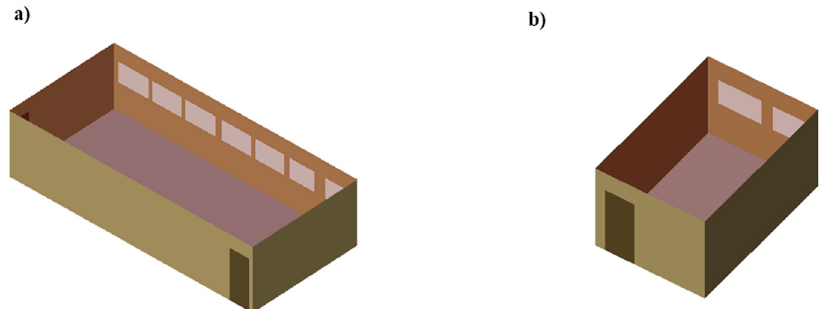
Figure 10. The gbXML models for ( a ) case study 1 and ( b ) case study 2. The ceiling was given transparency to improve visualization.